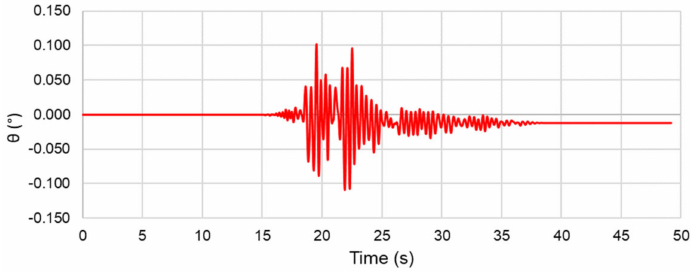
Figure 9. Rotation time-histories of the caisson, for the seismic input n. 1 (F a = 1.5).